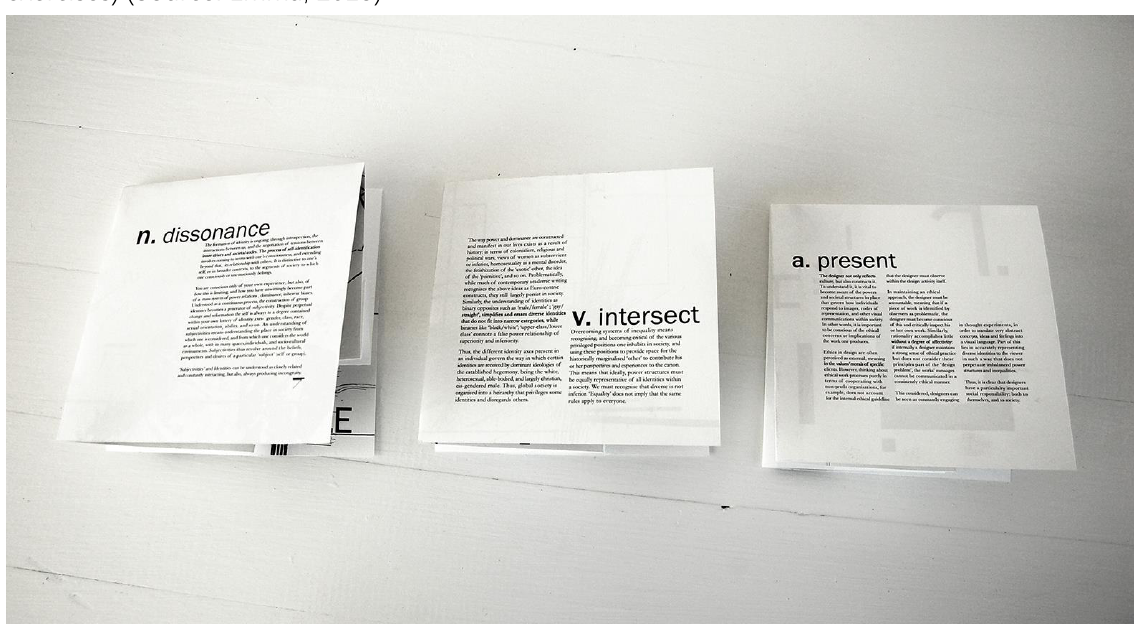
Figure 2.2 : Project 2: Mapping meaning through typographic play (Source: Emma,